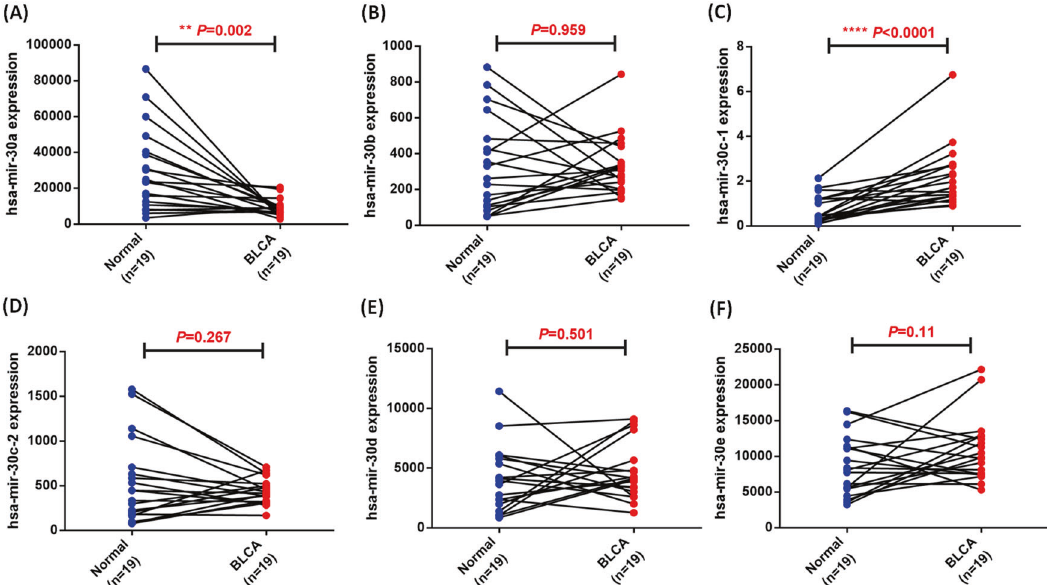
Fig. 1 Expression of hsa-miR-30 family members in the TCGA-BC dataset. ( A – F ) In the paired samples of BC tissues and adjacent normal tissues ( N = 19), the expression levels of hsa-miR-30 members were determined through a paired t -test. * P < 0.05, ** P < 0.01, *** P < 0.001, and **** P < 0.0001 relative to the normal group.